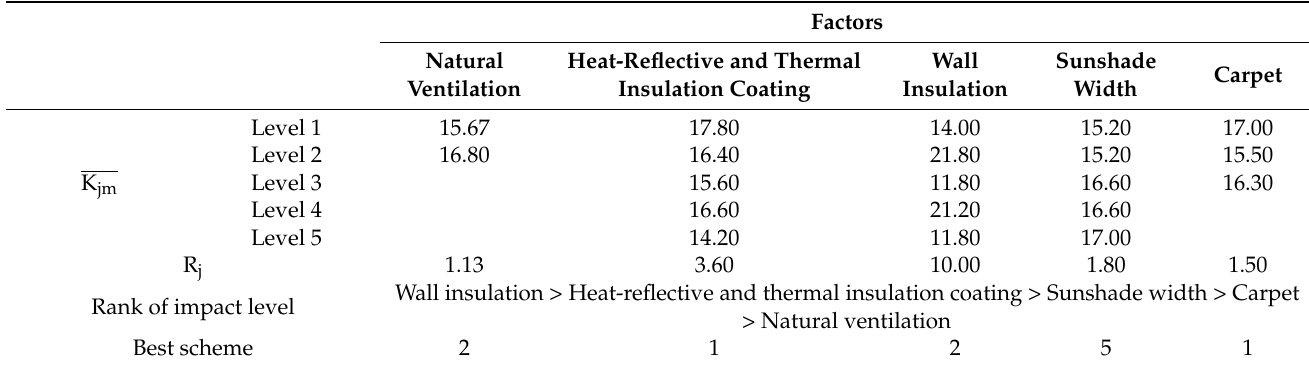
Table 12. Sensitivity analysis of the comprehensively optimized